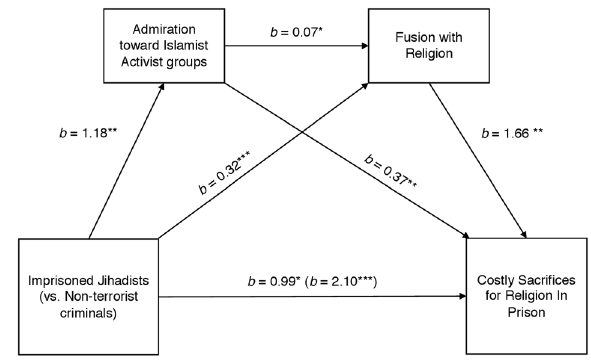
Fig. 1 Linear mediation model in Study 1 ( N = 71). Jihadists expressed more willingness to engage in costly sacri fi ces for religion in prison via (1) admiration toward radical Islamist groups alone, b = 0.44, s.e. = 0.25, 95% CI [0.02, 0.97], (2) fusion with religion alone, b = 0.54, s.e. = 0.29, 95% CI [0.13, 1.22], and (3) admiration and fusion serially, b = 0.13, s.e. =